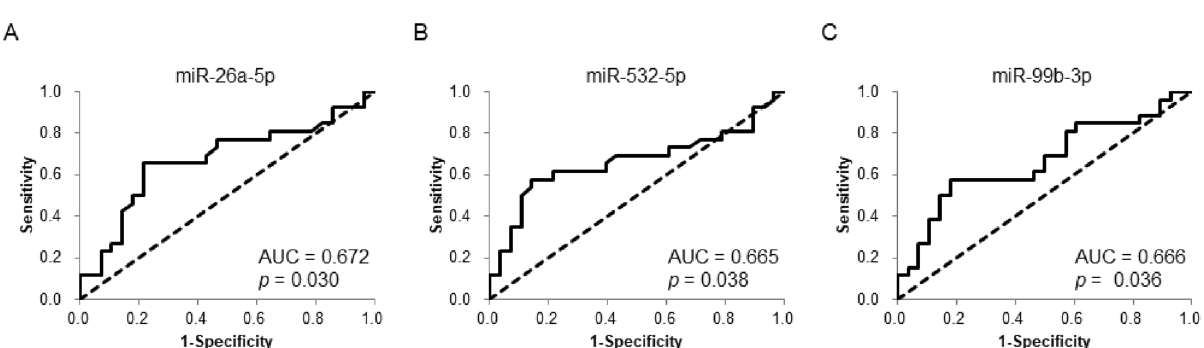
Figure 1. Validation of 4 miRNAs using RT-qPCR analysis. Relative expression levels of miR-26a-5p ( A ), miR- 532-5p ( B ), miR-99b-3p ( C ), and miR-363-3p ( D ) in 28 non-BCR and 26 BCR prostate cancer patients. RNU6B was used as an internal control to normalize the data.